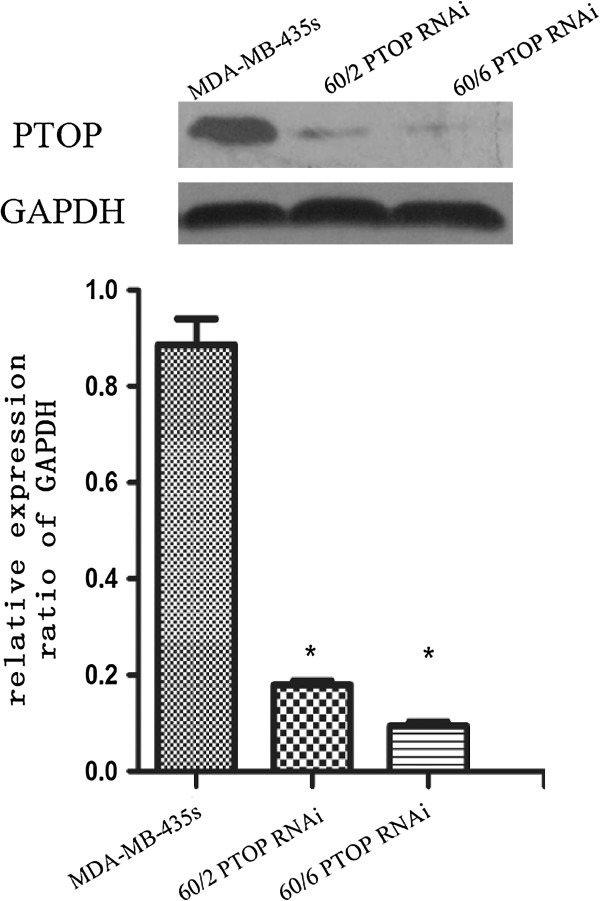
Knocking down PTOP protein in different groups. Western blot showed the PTOP knocking down expression in different groups. Compare with the MDA-MB-435 s cell, the expression of 60/2 PTOP RNAi and 60/6 PTOP RNAi cells were significant decreased. The bar graph showed the semiquantitative analysis of PTOP knocking down expression. Data represented means ± SD, *p < 0.05 was considered significant.